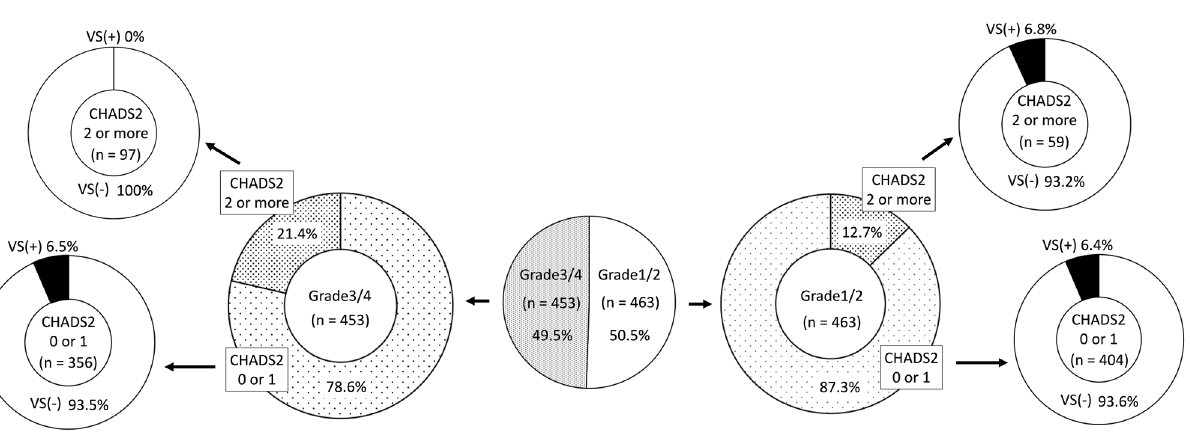
Figure 1. Schematic diagram showing the distribution of SSNHL patients stratified by hearing loss grade, CHADS 2 score, and presence or absence of vestibular schwannoma. No vestibular schwannoma (VS) was detected in Grade 3–4 patients with a CHADS 2 score of 2 or